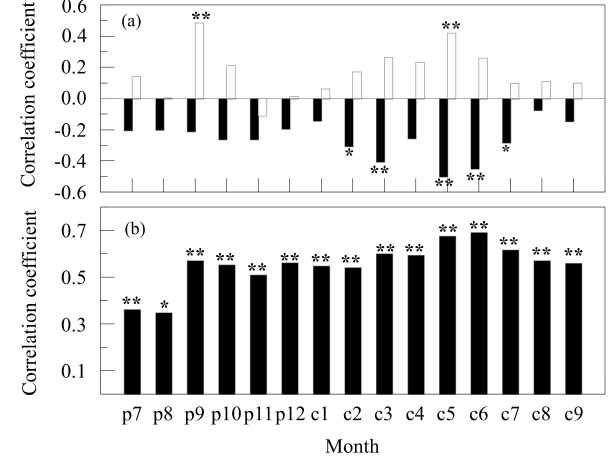
Fig. 4. Correlations of the ring-width indices with (a) the monthly mean temperature (black bars) and monthly precipitation (white bars) records obtained from the Jiexiu station during 1954–2008AD and (b) PDSI data during the interval of 1954–2005AD. ∗ indi- cates correlations exceeding the 0.05 confidence level; ∗∗ indicates correlations exceeding the 0.01 confidence level; p : previous year; c : current